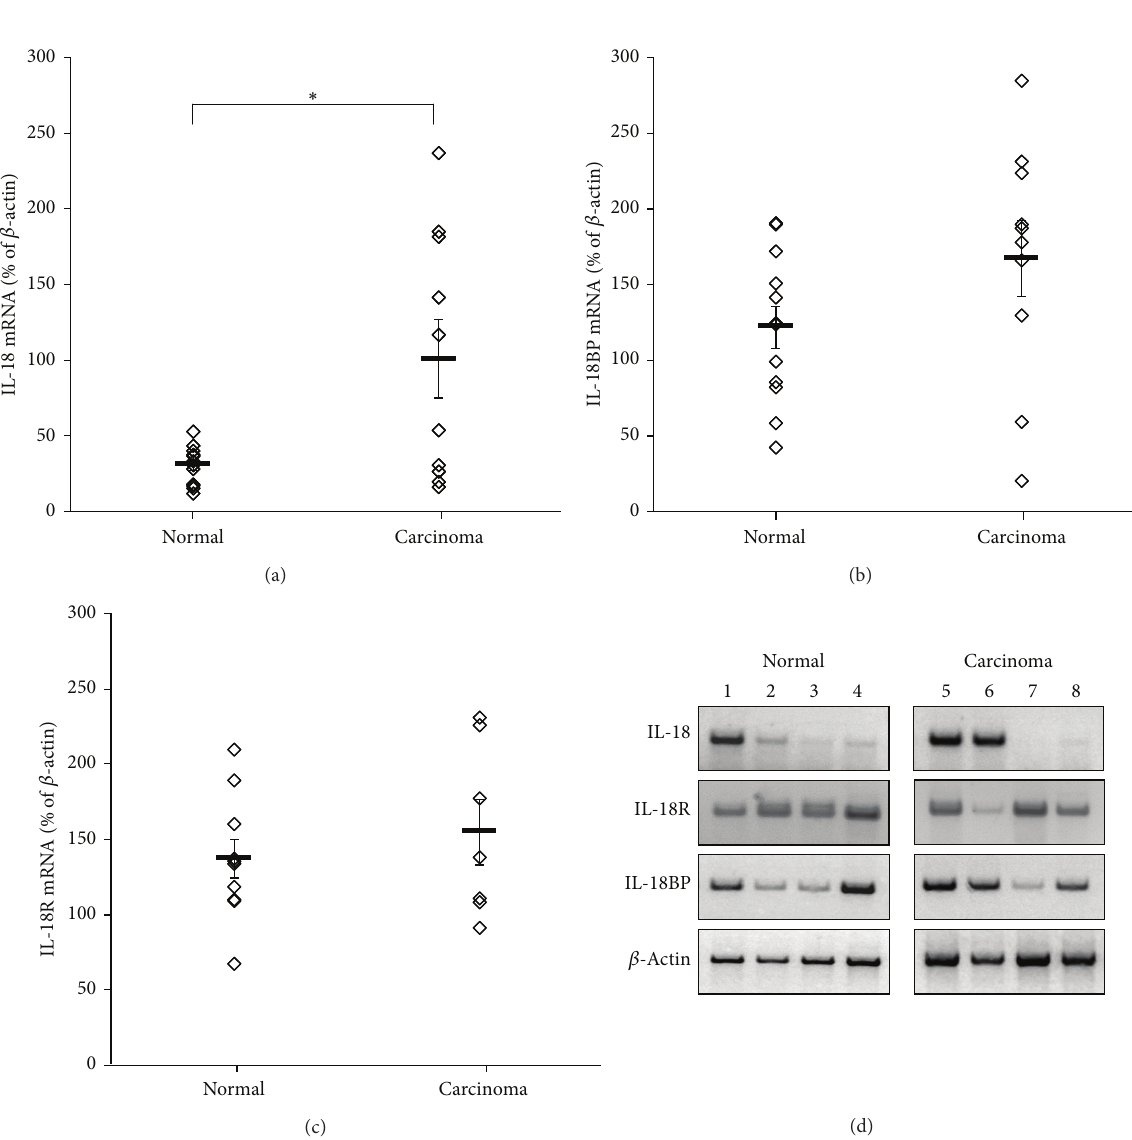
Figure 2: IL-18, IL-18BP, and IL-18R mRNA levels in normal and cancerous ovarian homogenates. Normal and cancerous ovarian samples were homogenized. The expression levels of IL-18 (a), IL-18BP (b), and IL-18R (c) mRNA were evaluated by semiquantitative RT-PCR. Quantitative evaluation of the positive PCR products was performed by densitometry. Each point represents the ratio between IL-18, IL- 18BP, or IL-18R bands and 𝛽 -actin bands of the same sample; 𝑛 = 13 and 10 in (a), 12 and 10 in (b), and 10 and 7 in (c), for the normal and carcinoma samples, respectively. Horizontal lines indicate MEAN ± SEM. (d) Representative samples of normal (1–4) and cancerous (5–8) ovarian tissues are presented. ∗ indicates statistical significance according to 𝑡 -test: ∗ 𝑃 = 0.025